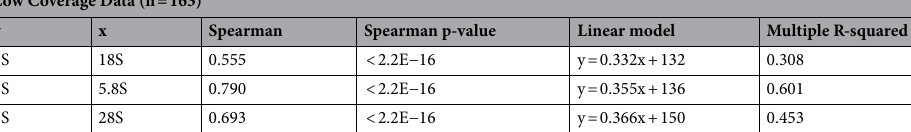
Table 4. Correlations between 45S and 5S rDNA copy numbers in the low-coverage 1000 Genomes Project dataset. The Spearman correlation coefficient and linear models that describe the relationships between the 45S and 5S rDNA copy numbers are